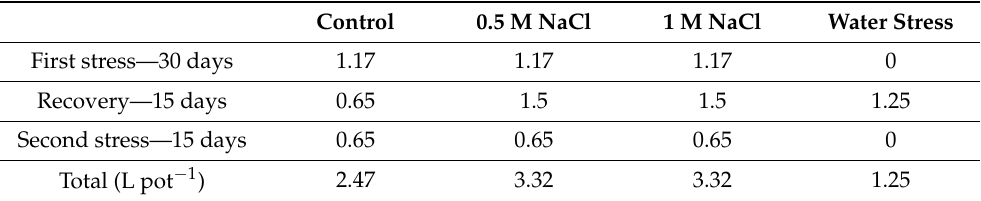
Table 2. Total amount of water (L pot − 1 ) distributed during the two stress periods and the recovery phase in the four treatments. Control 0.5 M NaCl 1 M NaCl First stress—30